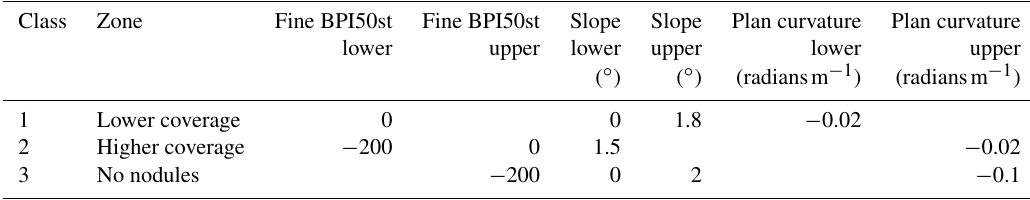
Table A5. Classification dictionary for the classification of the AUV-mapped study area used with the BTM to reveal areas of possible lower Mn-nodule coverage.